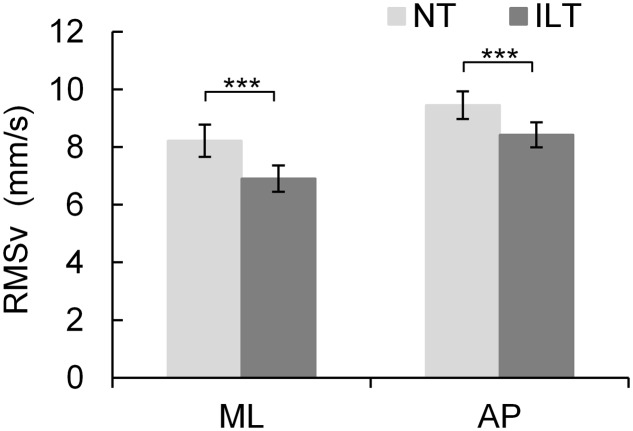
Average RMSv (mm/s) (± standard error) of all participants (n = 48, individual). NT (light gray), no touch condition; ILT (dark gray), interpersonal light touch condition. ∗∗∗ RMSv in both axes (ML and AP) of the ILT condition was significantly lower than that of NT (P < 0.001). RMSv, root mean square of center of foot pressure velocity; ML, mediolateral; AP, anteroposterior.